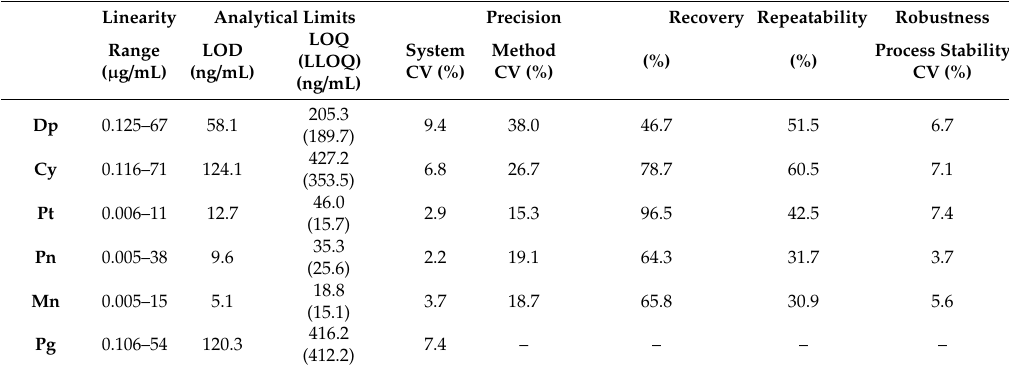
Table 1. Validation parameters of anthocyanidins in